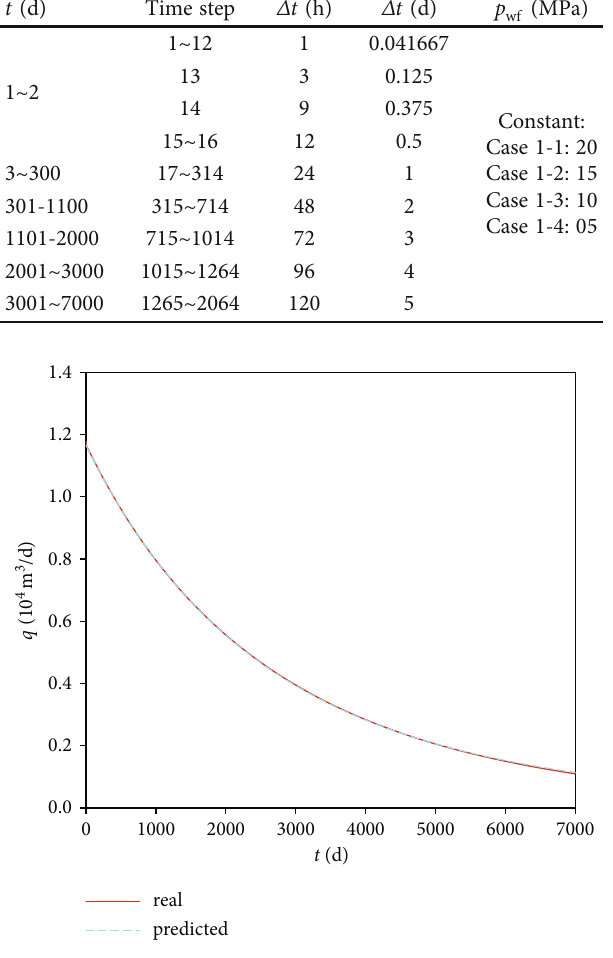
Figure 6: The real production rate pro fi le and the predicted pro fi le by the HDM for Case 1-1.